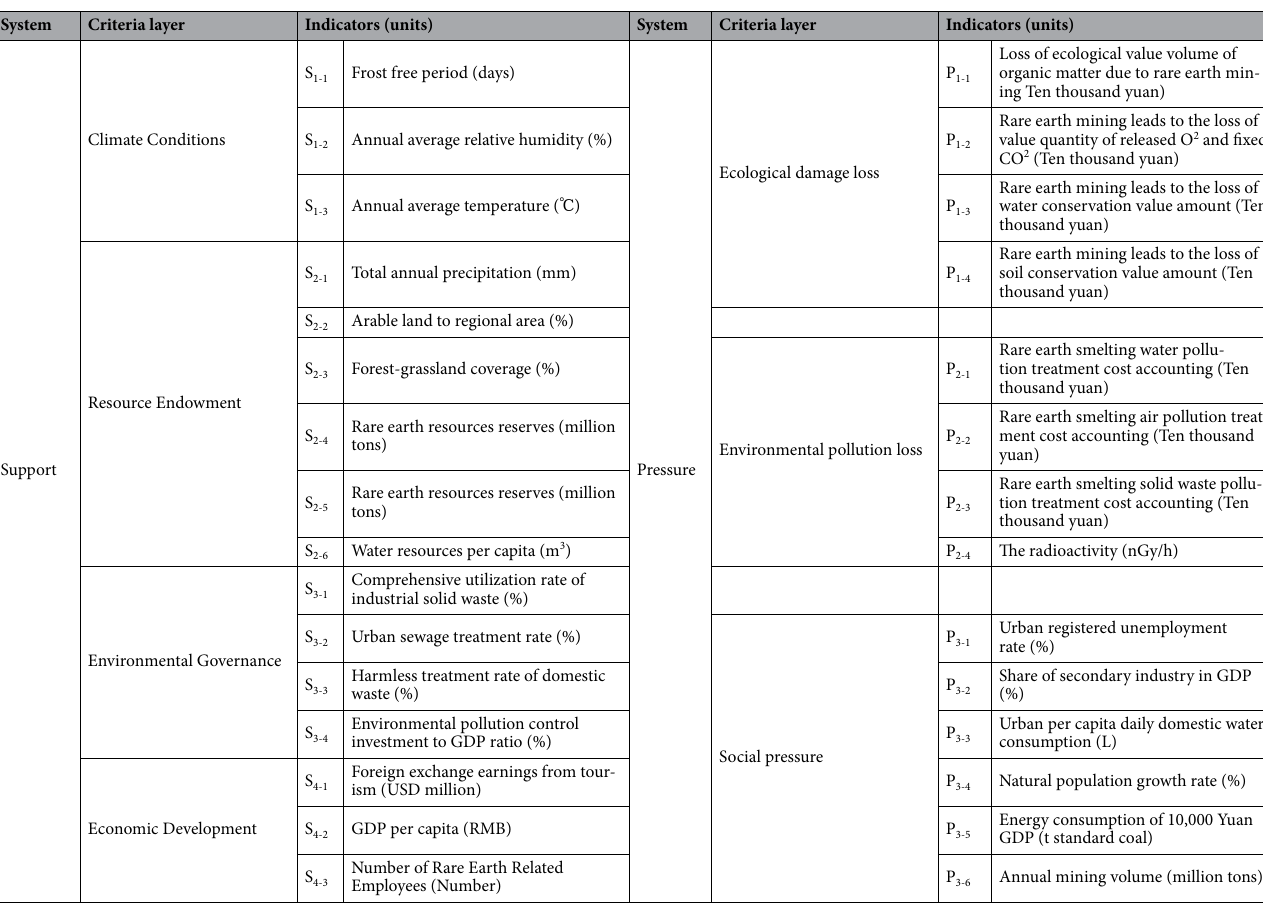
Table 2. Evaluation index system of the